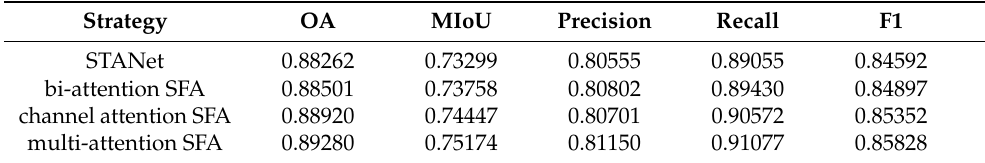
Table 9. The experiment results on the SYSU-CD dataset with four strategies.